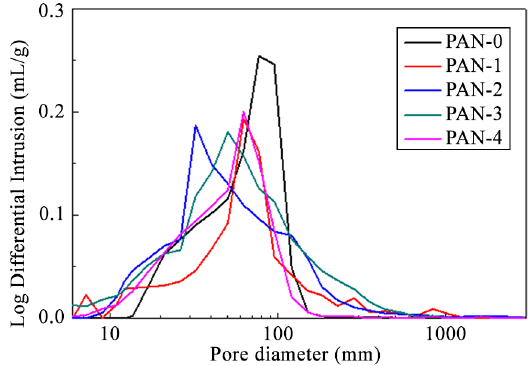
Figure 4. MIP analysis of pore parameters of PAN fiber reinforced concrete.